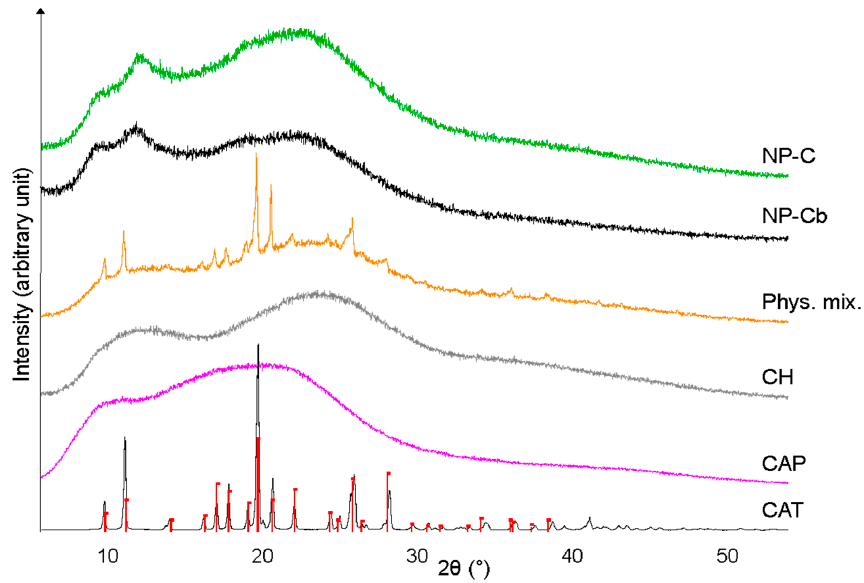
Figure 5. XRD patterns of CAT, CAP, CH, physical mixture, NP-Cb and NP-C; red bars: Powder Diffraction File 35–1916 (captopril).